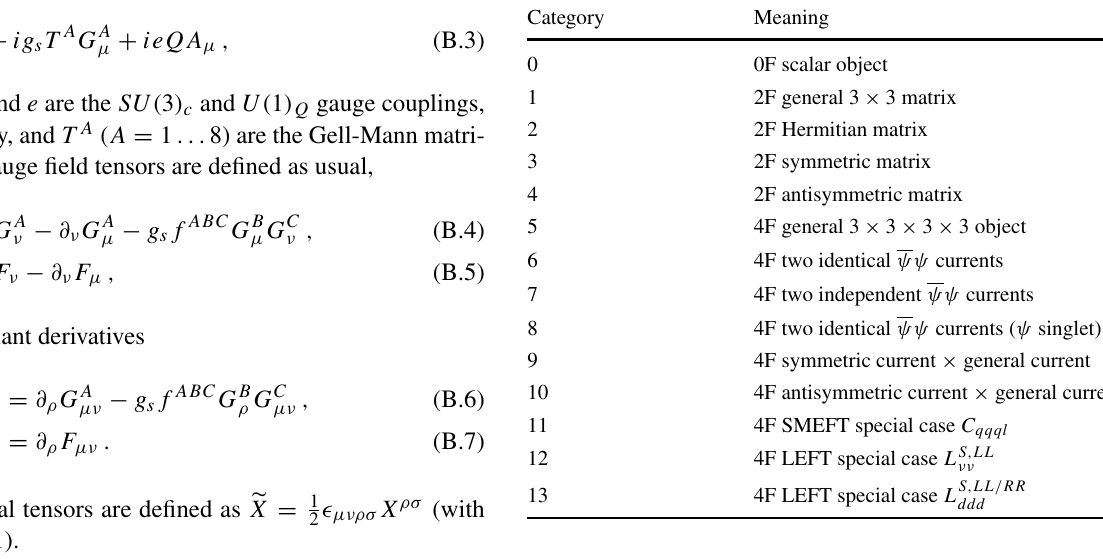
Table 14 Index symmetry categories used in DsixTools